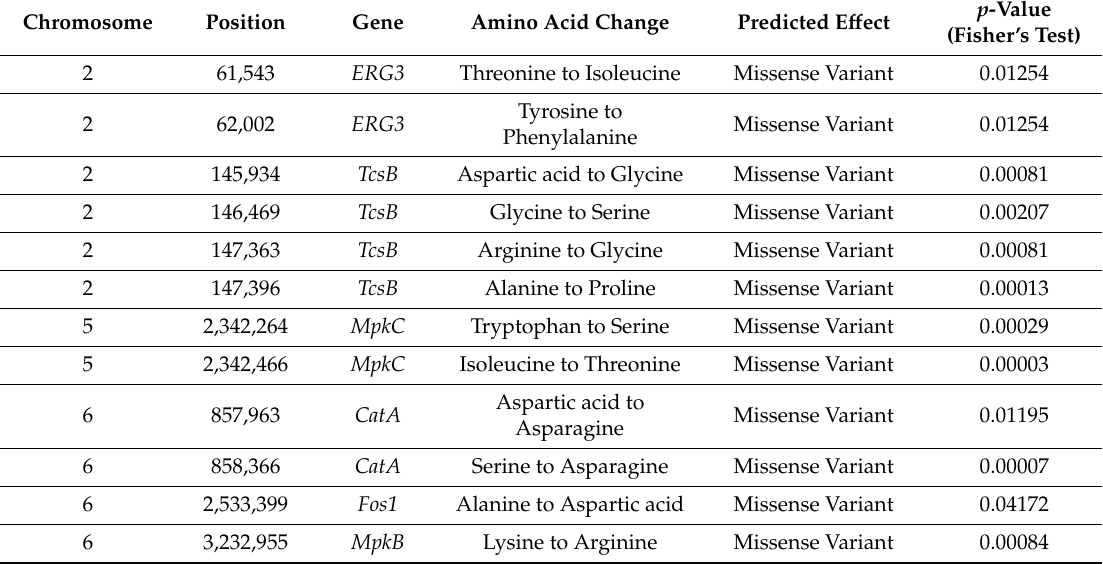
Table 5. Non-synonymous SNPs located in six of the 22 genes of interest that are significantly associated with AMB resistance / sensitivity based on Fisher’s Exact test ( p <